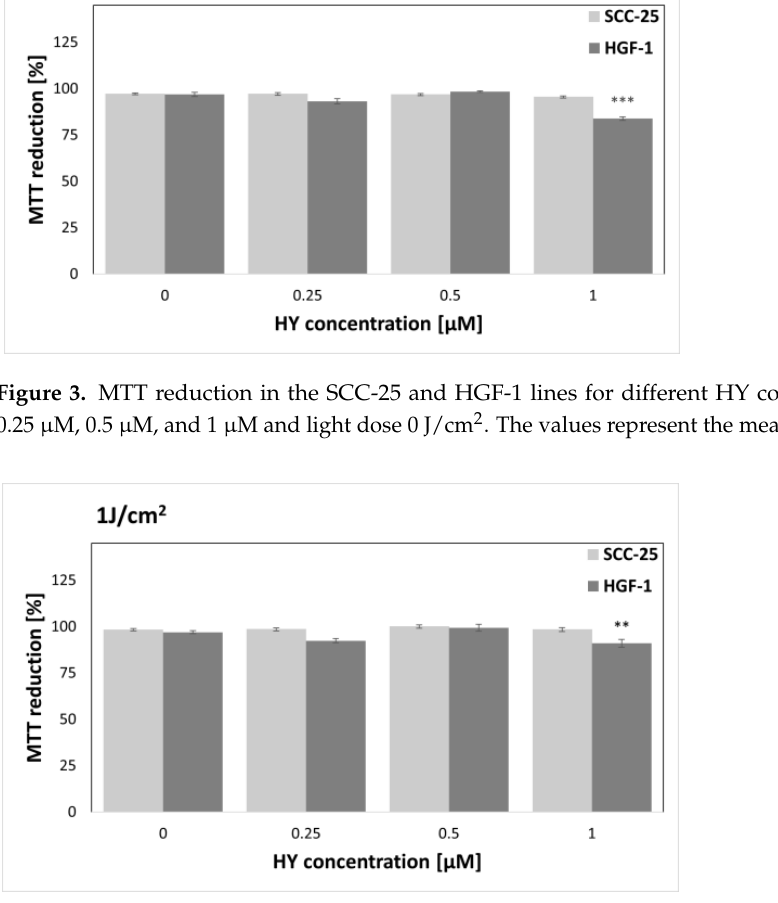
Figure 4. MTT reduction in the SCC-25 and HGF-1 lines for different HY concentrations: 0 µM, 0.25 µM, 0.5 µM, and 1 µM and light dose 1 J/cm 2 . The values represent the means ± SE. ** p < 0.05.